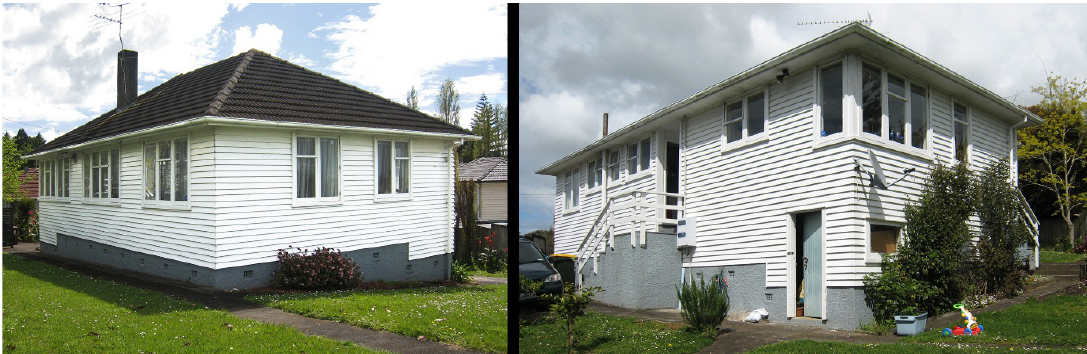
Figure 3. South-west (street side) and north-east (backyard side) views of the pilot project house in 2012.